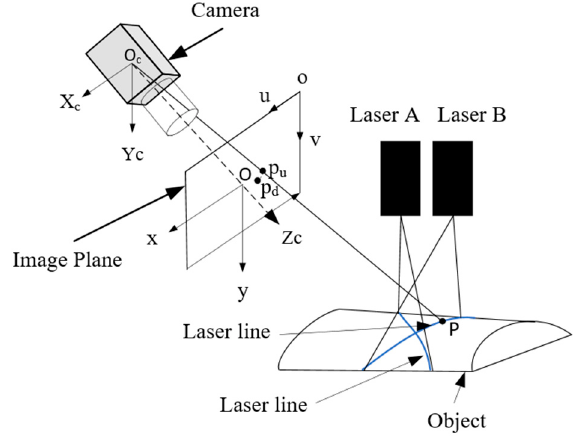
Figure 2. Cross-line projector with a single fixed camera.